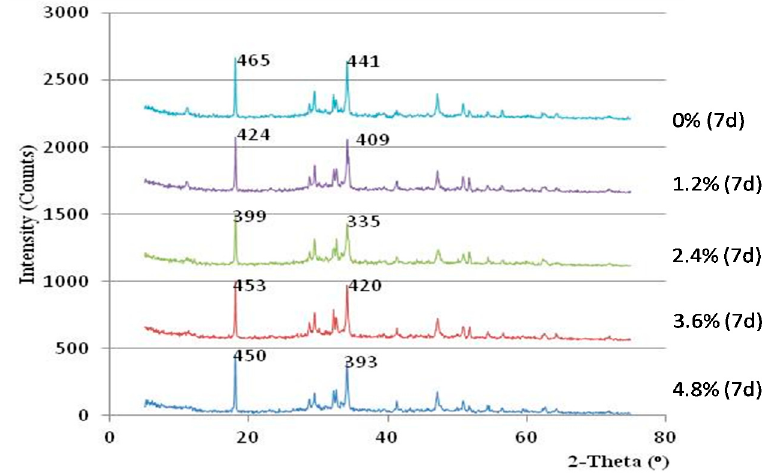
Figure 9. XRD curve of the hardened cement samples after seven days of curing.